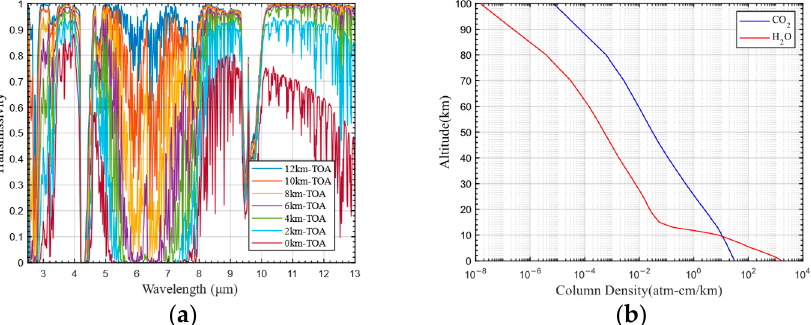
Figure 17. Atmospheric transmittance from different altitudes to the top of the atmosphere and atmospheric profile of CO 2 , H 2 O, derived from output files of the MODTRAN .